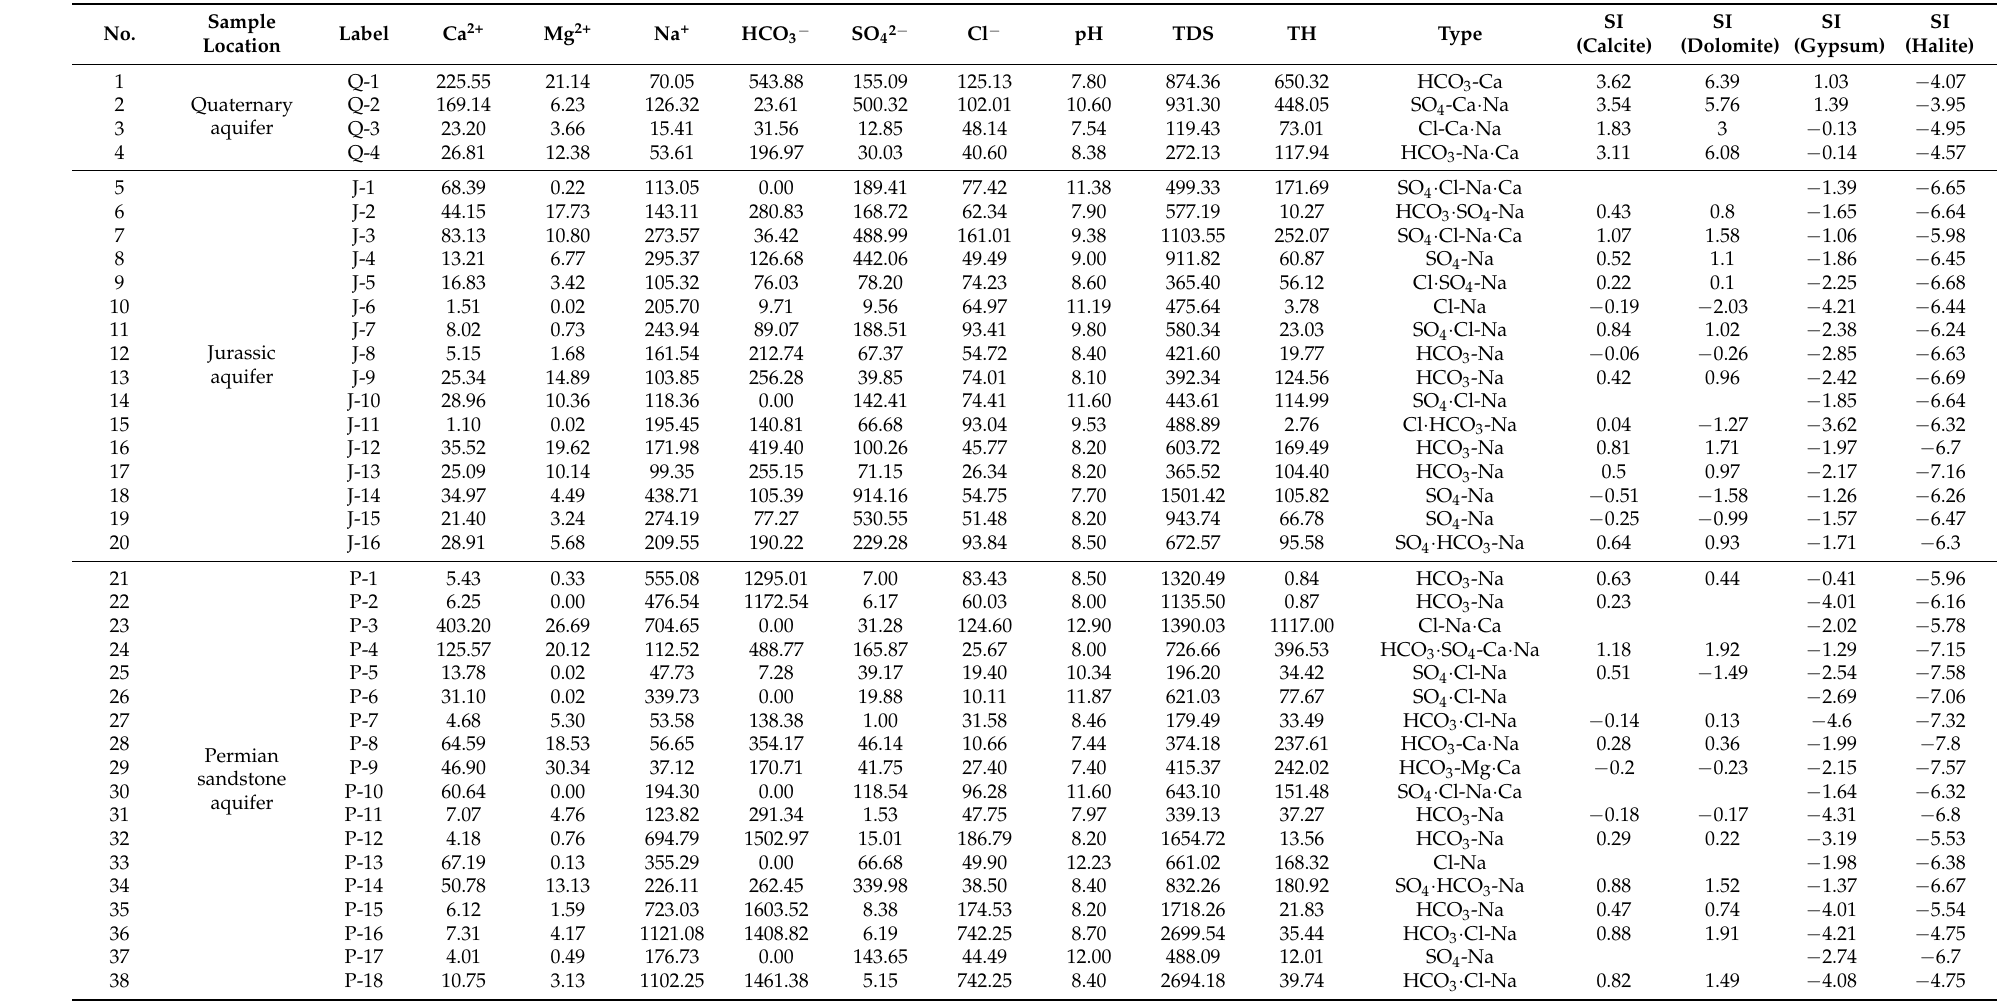
Table 1. Groundwater samples from the Dongtan Coal Mine (all indices are expressed in mg · L − 1 except pH and Saturation Index (SI)).